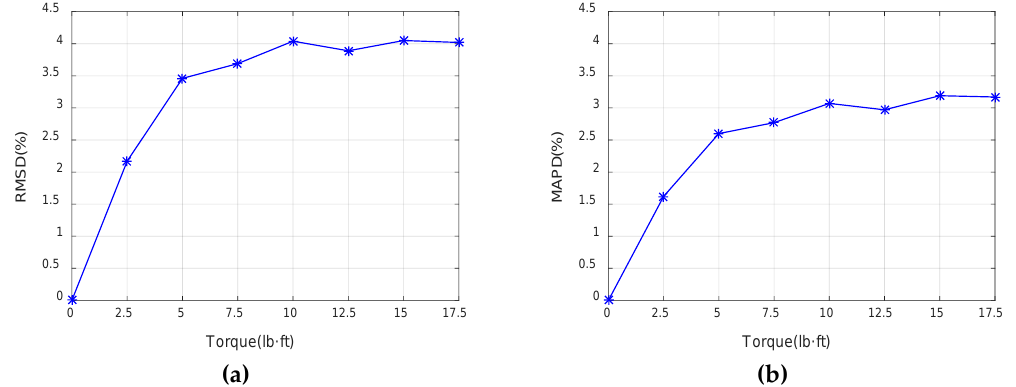
Figure 9. Conductance signatures at different torque level (200–220 kHz).